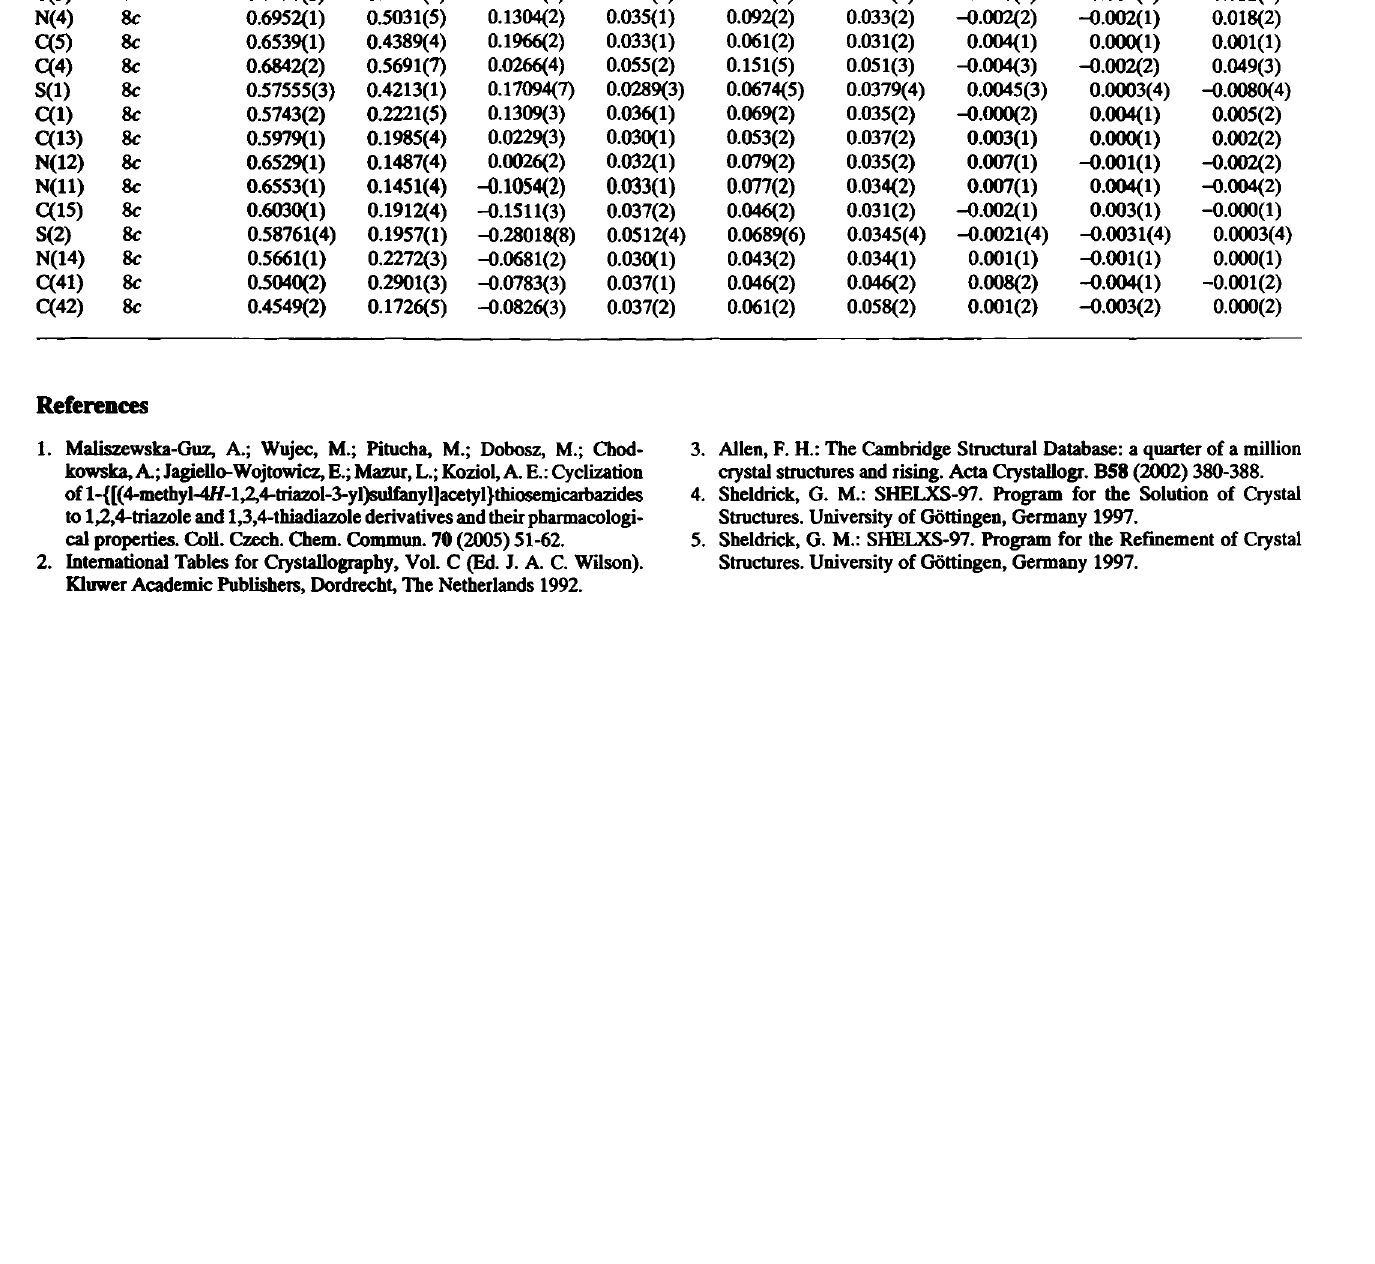
Table 3. Atomic coordinates and displacement parameters (in A 2